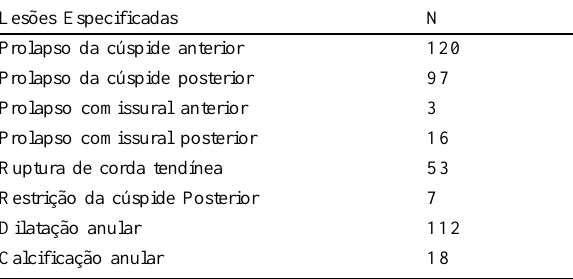
Tabela 3. Lesões observadas no